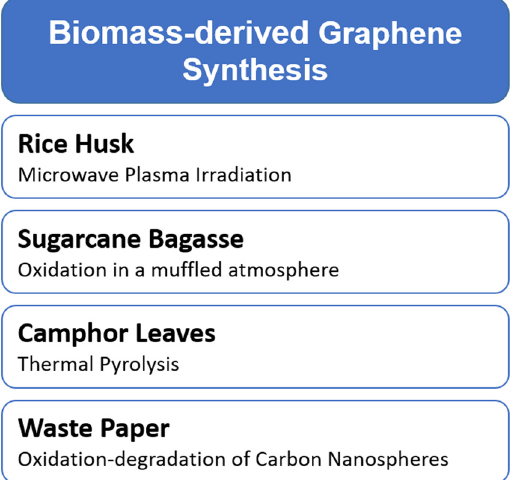
Figure 8: Biomass precursors and methods for graphene